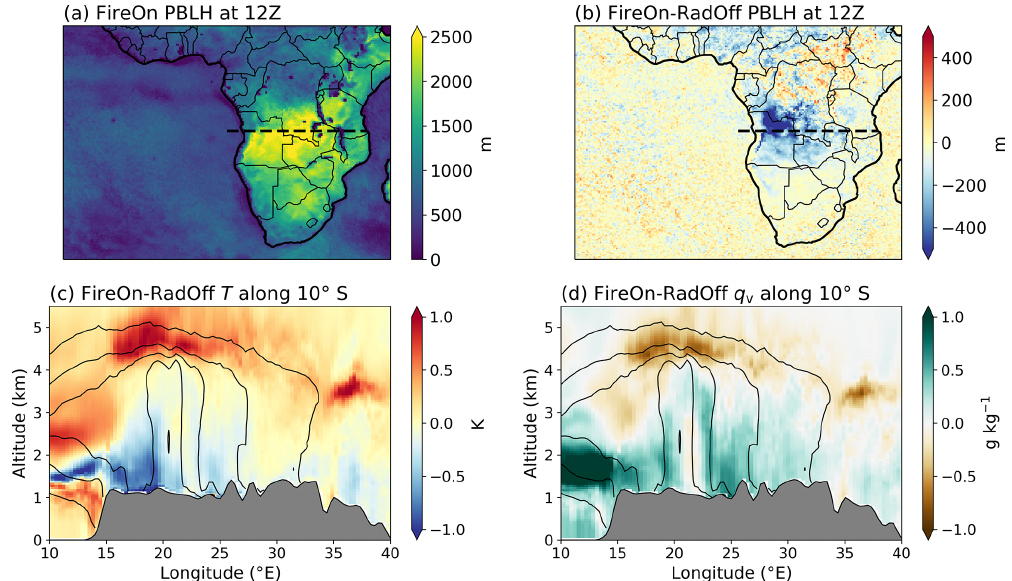
Figure 9. Effects of smoke absorption on continental convection. WRF-diagnosed planetary boundary layer height at 12:00UTC for (a) FireOn and (b) the FireOn–RadOff difference over the full domain (40 ◦ S–15 ◦ N, 30 ◦ W–50 ◦ E). The dotted lines in panels (a) and (b) indicate the locations of the profiles (along 10 ◦ S from 10 to 40 ◦ E) of FireOn–RadOff (c) temperature and (d) specific humidity. Thermo- dynamic differences in panels (c) and (d) are averaged over 14–20 August 2017 at all times. Black contours represent black carbon mass concentration at intervals of 0.5µgkg − 1 . Grey shading represents the continental land